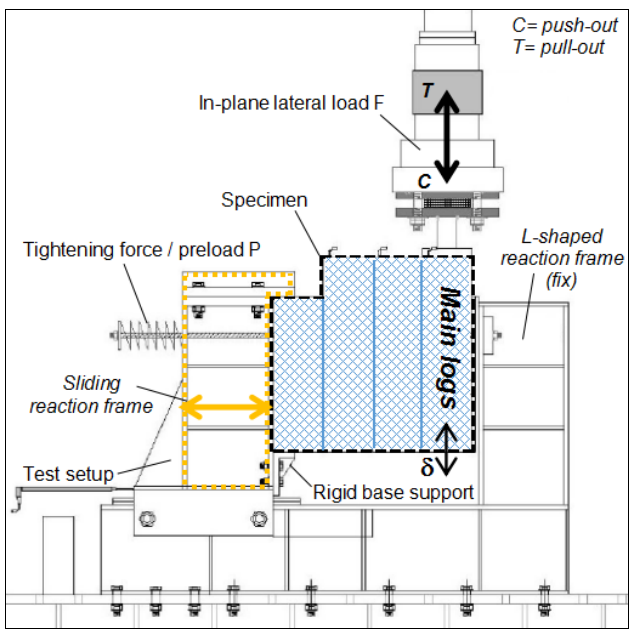
Figure 2. Schematic drawing of the testing apparatus (front view), in accordance with References [12,13].